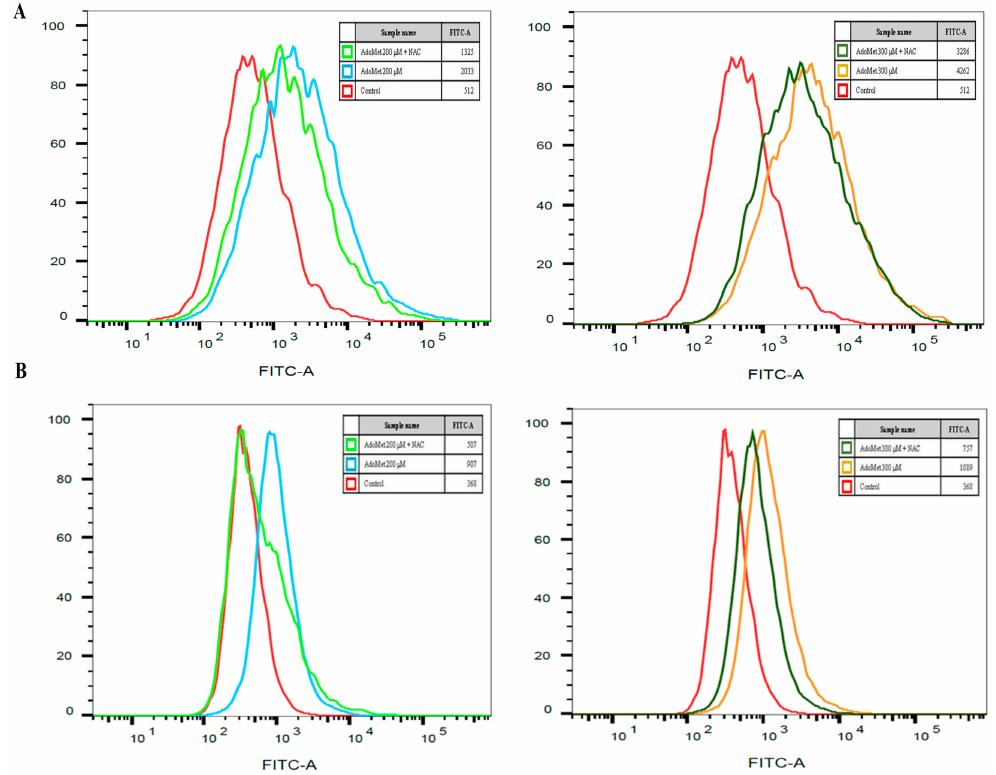
Figure 3. E ff ect of AdoMet on ROS accumulation in LSCC. ( A ) JHU-SCC-011 and ( B ) HNO210 cells were treated, or not (Control), with 200 and 300 µ M AdoMet for 72 h with or without pretreatment with 5mM NAC and then subjected to flow cytometry to measure ROS levels. FACS analysis was performed using 2 (cid:48) ,7 (cid:48) -dichlorofluorescein diacetate (DCF-DA) as a substrate. For the quantitative evaluation of ROS, FlowJo software was used to calculate median fluorescence intensities (MFI) by the formula (MFI-treated / MFI-control). Analysis was carried out by triplicate determination on at least three separate